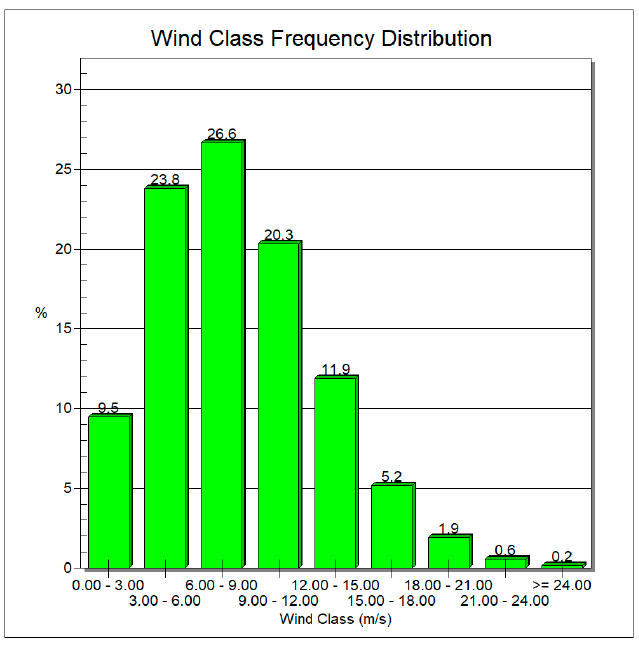
Figure 10. Percentage of wind blowing in different wind speed ranges at the Foveaux site. The yearly hour wind blows from different directions on Stewart Island are shown in Figure 11. It is generated from a wind model commissioned by Stewart Island Electricity Supply (SIESA) [40]. The wind model adopts local Stewart Island meteorological records according to terrain elevation and